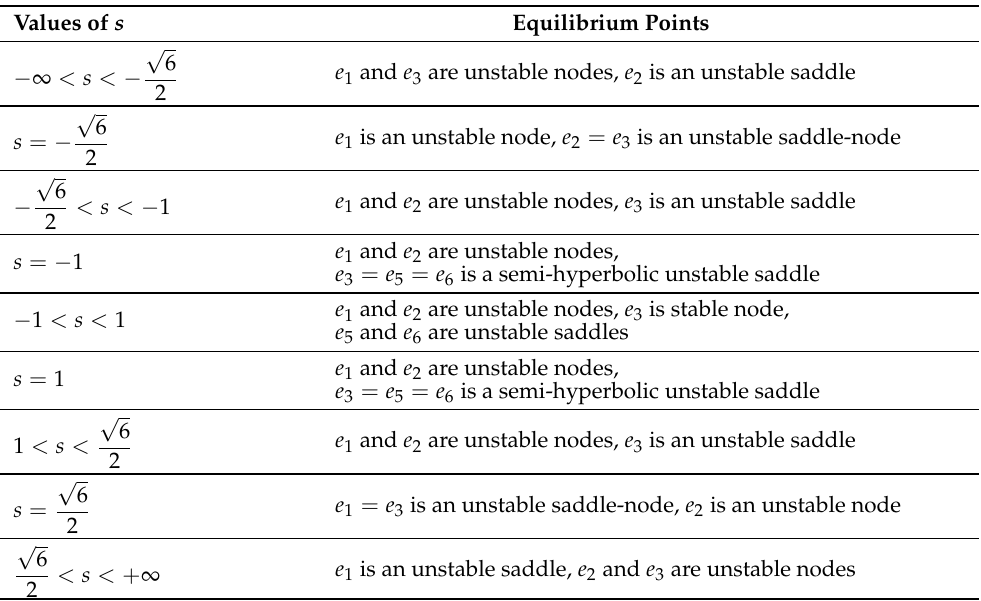
Table 2. Equilibrium points for the different values of s , where e 1 = ( 1,0 ) , e 2 = ( − 1,0 )